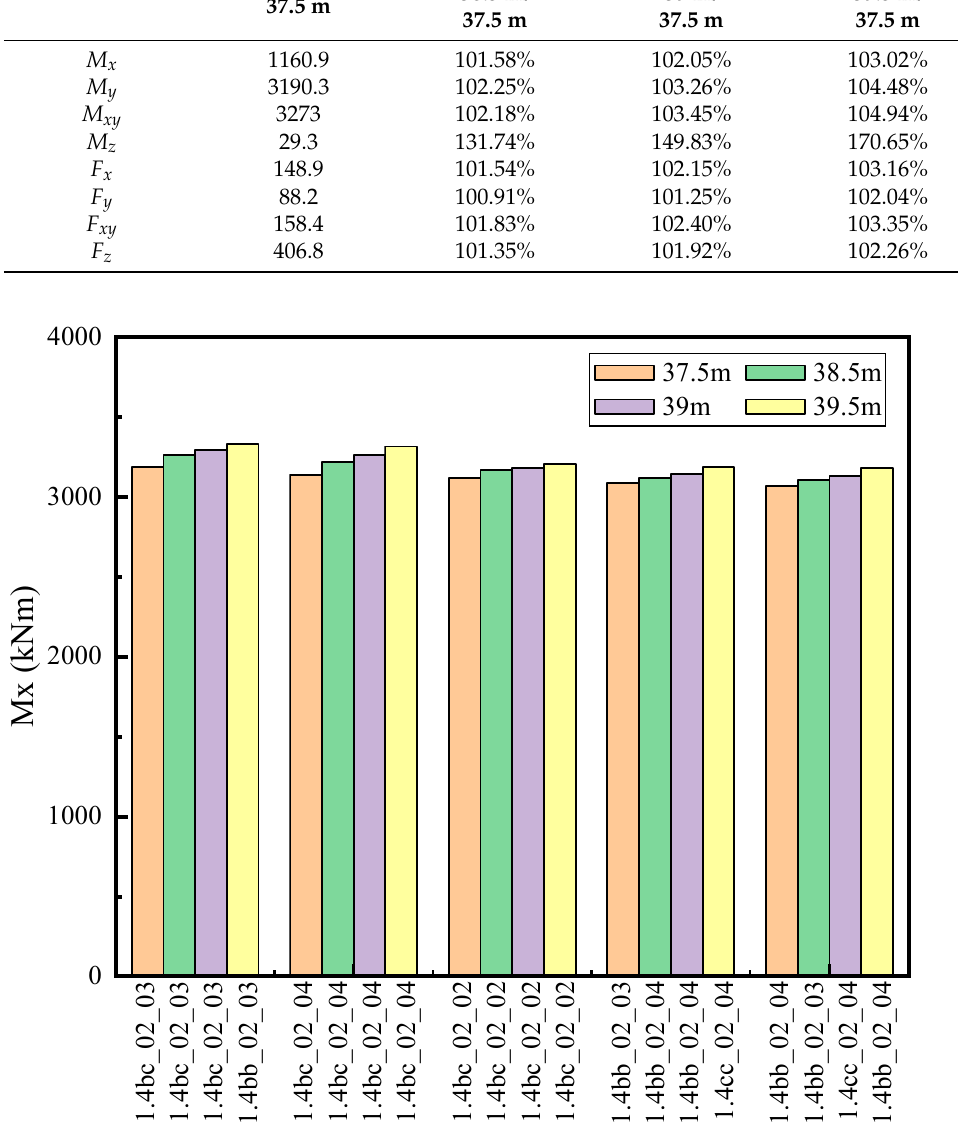
Figure 16. Histogram of M y at blade root. (The label of the load cases: the first letter refers to wind speed, “b” for 11.5 m/s and “c” for 13.5 m/s; the second letter refers to yaw error, “b” for 0 deg and “c” for 8 deg; the middle number refers to wind direction change and 02 for negative direction change; the last number refers to starting azimuth angle, 02 for 30 deg, 03 for 60 deg and 04 for 90 deg). Table 14. Ultimate load M y at blade root. (The label of the load cases: the first letter refers to wind speed and “b” for 11.5 m/s; the second letter refers to yaw error, “c” for 8 deg; the middle number refers to wind direction change and 02 for negative direction change; the last number refers to starting azimuth angle and 03 for 60